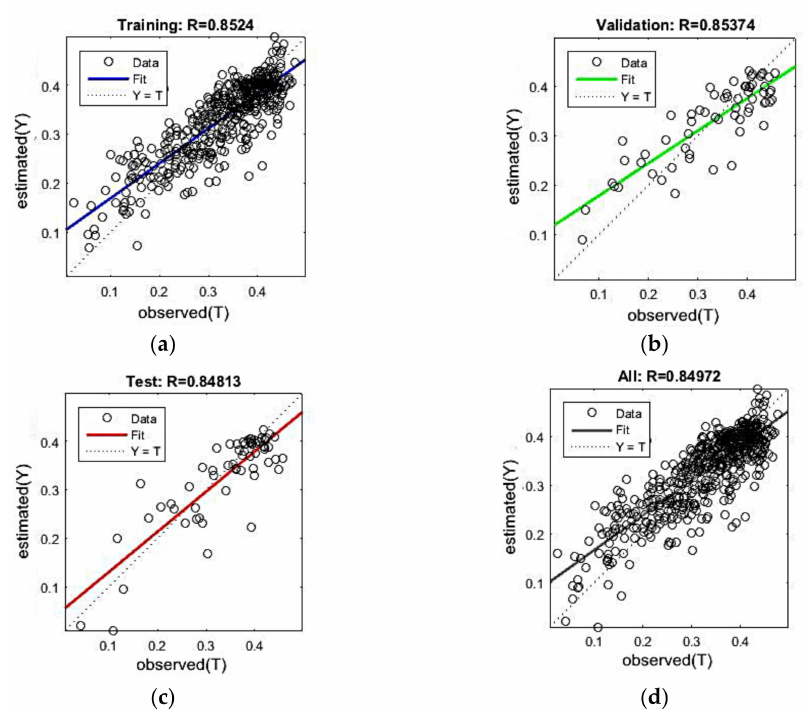
Figure 4. Scatter plots of SMC estimations for training ( a ), validation ( b ), testing dataset ( c ), and the entire samples ( d ). Corresponding correlation coefficients are placed above each